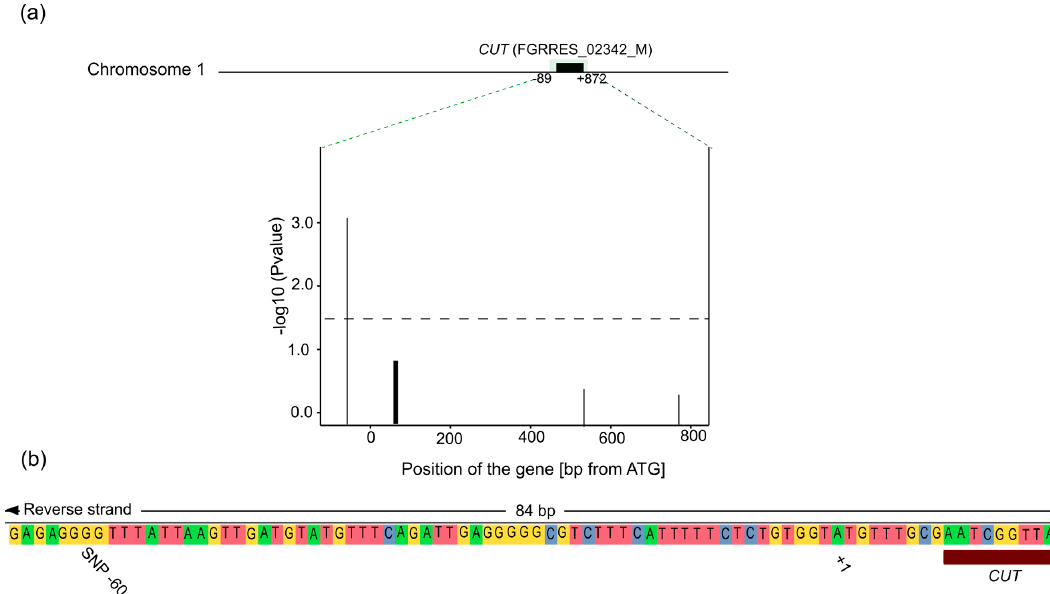
Figure 4. Significant association of SNPs with aggressiveness of 100 Fusarium culmorum isolates in the candidate gene cutinase ( CUT ). ( a ) Amplified region of the CUT gene on chromosome 1. The significance ( − log 10 of p value) of 17 SNPs was tested for this gene, each bar corresponds to one SNP. The significance by the cut-off at p < 0.05 is shown by the dashed horizontal black line. ( b ) Location of the significantly associated SNP according to the ATG codon.